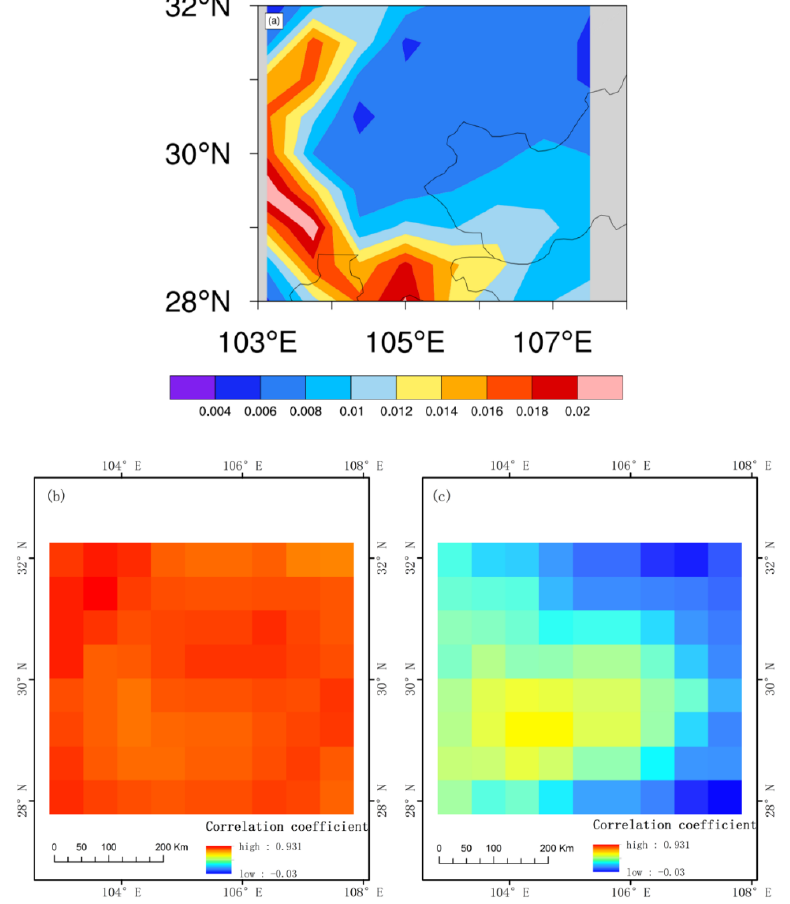
Figure 9. The spatial distribution of BC wet deposition flux (unit: µ g m − 2 s − 1 ) ( a ), and spatial distributions of correlation coefficients of BC wet deposition flux with BC column mass density ( b ) and precipitation ( c ) over the Sichuan basin.